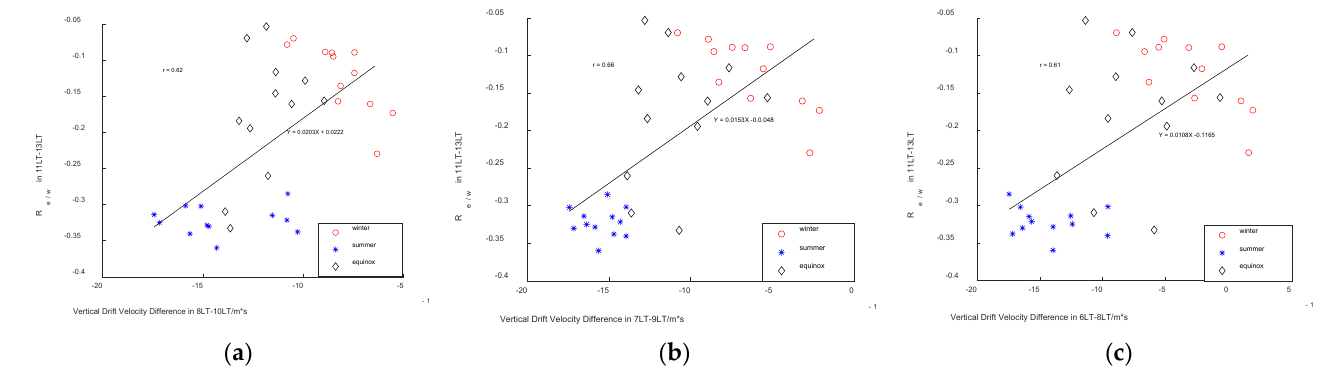
Figure 10. ( a ) Correlation between the TEC longitudinal difference index R e/w in 11LT–13LT and the corresponding vertical drift velocity difference in 8LT–10LT in low solar activity years. ( b ) Correlation between the TEC longitudinal difference index R e/w in 11LT–13LT and the corresponding vertical drift velocity difference in 7LT–9LT in low solar activity years. ( c ) Correlation between the TEC longitudinal difference index R e/w in 11LT–13LT and the corresponding vertical drift velocity difference in 6LT–8LT in low solar activity years.